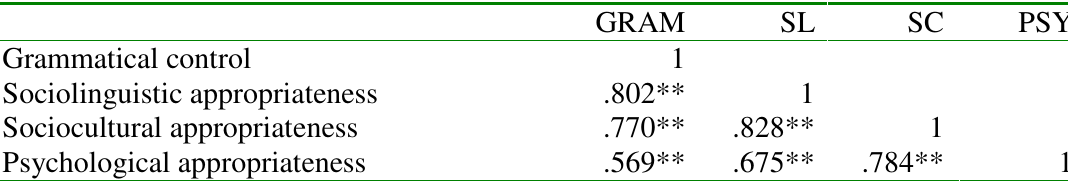
Relationship between Language Knowledge Components (N =